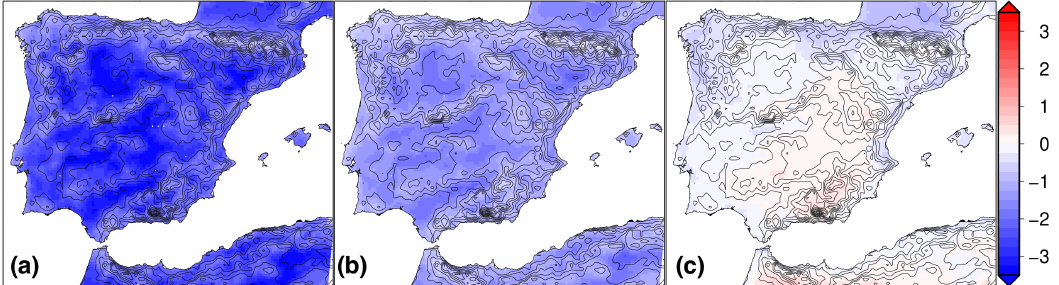
Figure 2. Differences between FVC90-FVC30 experiment for ( a ) minimum, ( b ) mean, and ( c ) maximum daily temperature ( ◦ C) averaged over the whole period. Black contours denote the